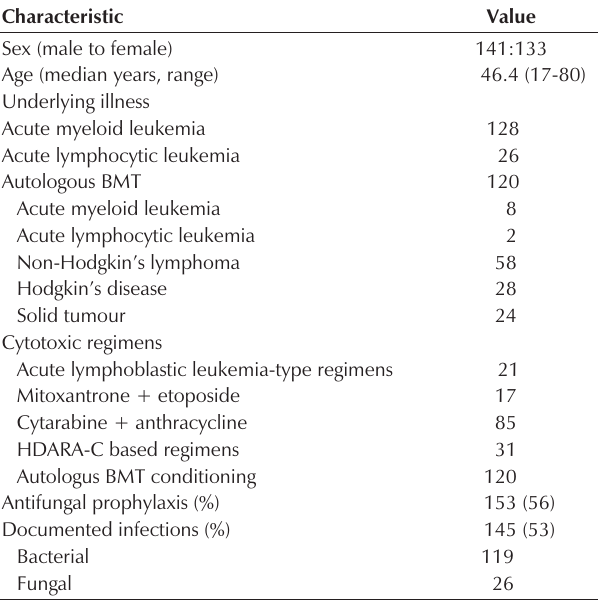
Characteristics of the 274 evaluable patients